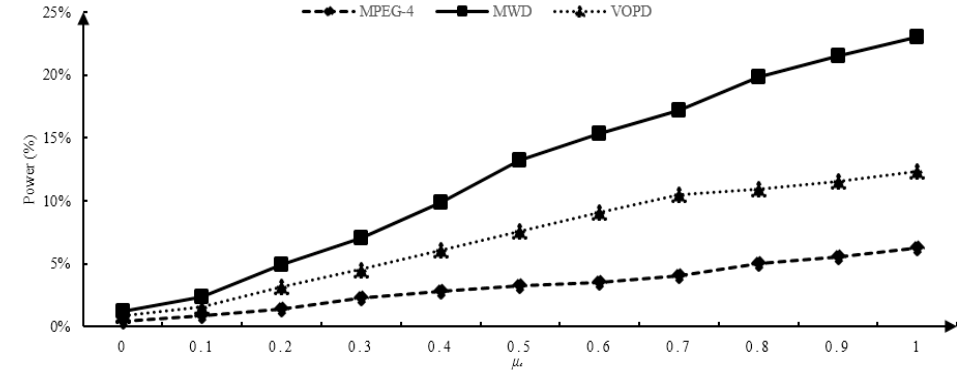
Figure 14. Influence of multi-objective optimization parameter μ e on power optimization results.